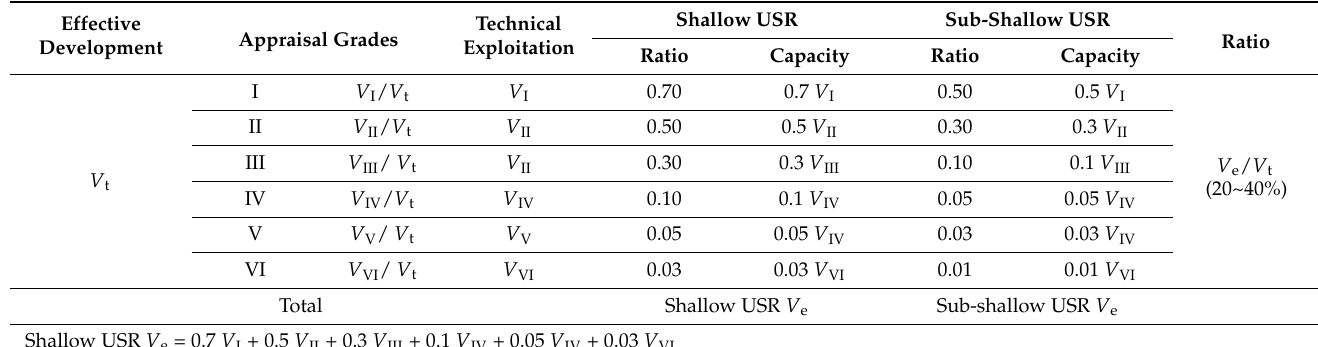
Table 12. Effective development capacity of USR calculation.